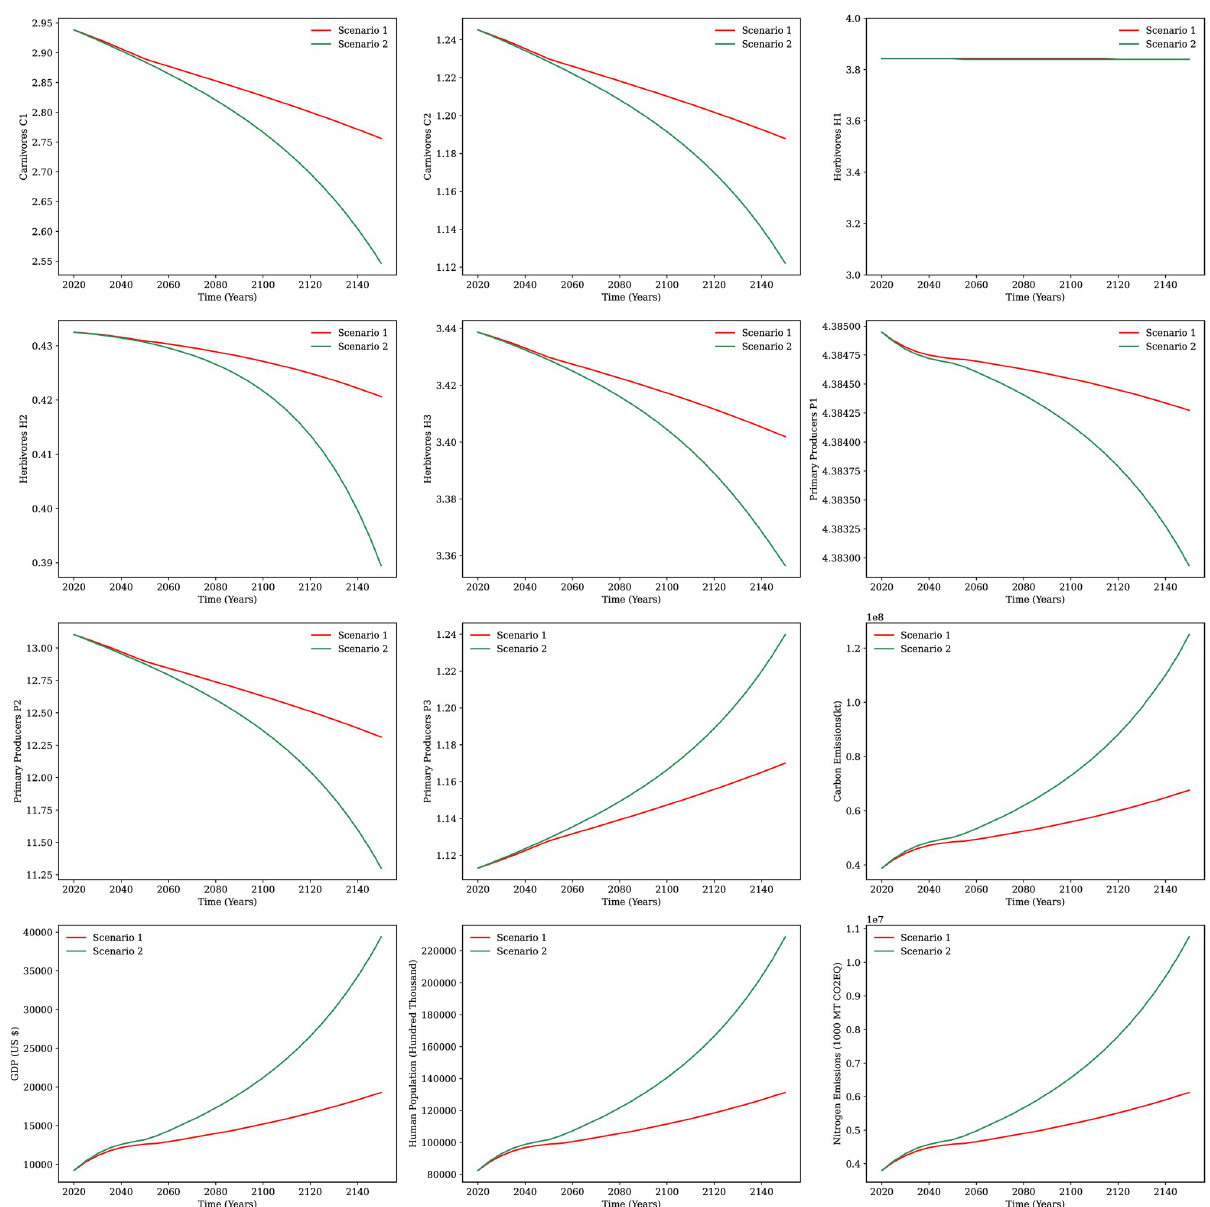
Fig 7. Results for all compartments for the base case scenario (scenario 1) and the population explosion scenario (scenario 2).